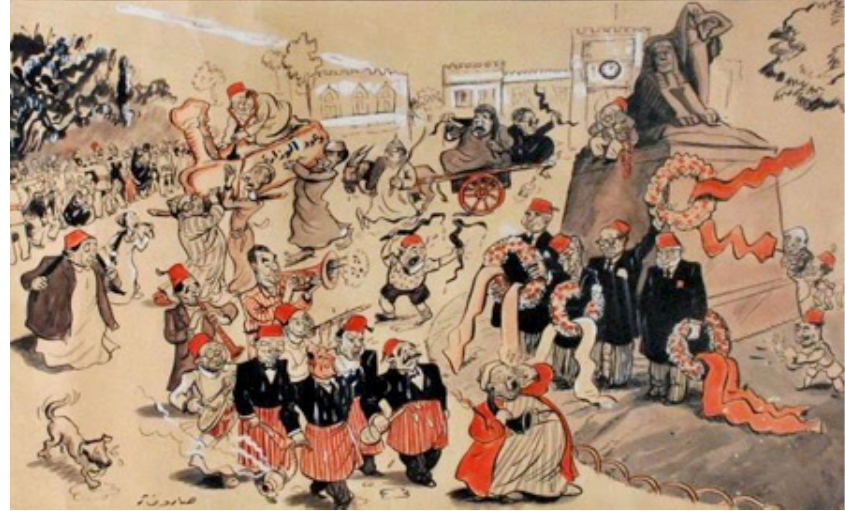
Figure 6 One of the caricature artist Two Missiles